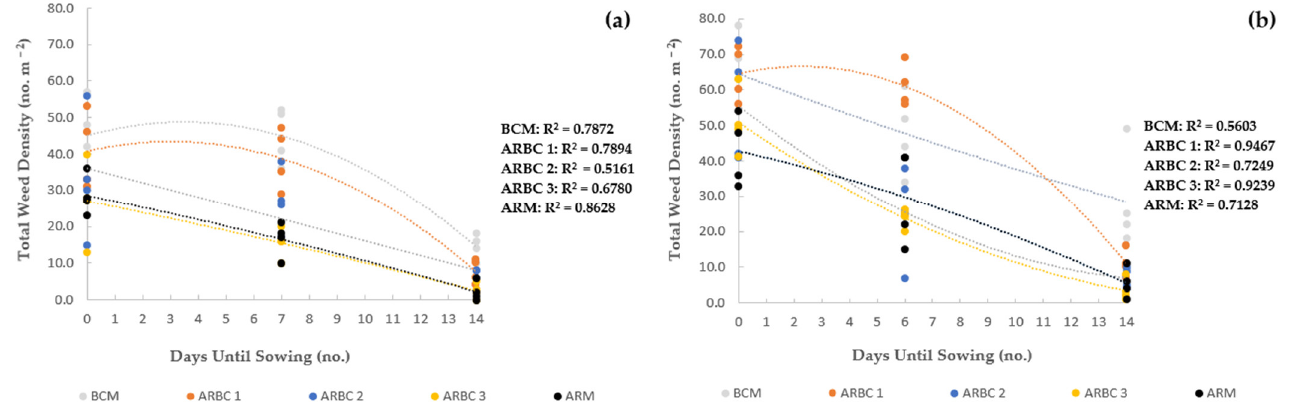
Figure 2. Second-degree polynomial relationships (y = ax 2 + bx + c, n = 12) between total weed den- sity (no. m −2 ; y) and days until sowing (no.; x) for each forage in ( a ) 2020–2021 and ( b ) 2021–2022 (“nο.” is the abbreviation of “number”). BCM: Berseem clover monoculture; ARBC 1: First intercrop with annual ryegrass and berseem clover in a 25:75 ratio; ARBC 2: Second intercrop with annual ryegrass and berseem clover in a 50:50 ratio; ARBC 3: Third intercrop with annual ryegrass and berseem clover in a 75:25 ratio; ARM: Annual ryegrass monoculture (see text in Section 2.2 for details on abbreviations).